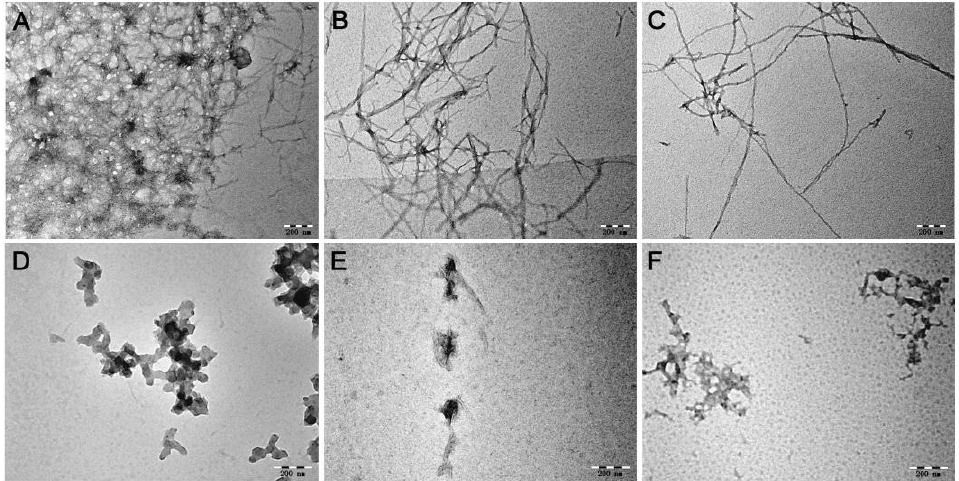
Figure 5. TEM images of A β 40 (20 μM) in the absence or presence of Zn 2+ , Cu 2+ , and MnPM after incubation at 37 °C and pH 7.4 for 24 h. ( A ) A β 40 + Zn 2+ ; ( B ) A β 40 + Cu 2+ ; ( C ) A β 40; ( D ) A β 40 + Zn 2+ + MnPM; ( E ) A β 40 + Cu 2+ + MnPM; ( F ) A β 40 + MnPM ([A β 40]:[metal ion]:[MnPM] = 1:2:1) (All the samples with final DMSO content: volume ratio 0.5%).